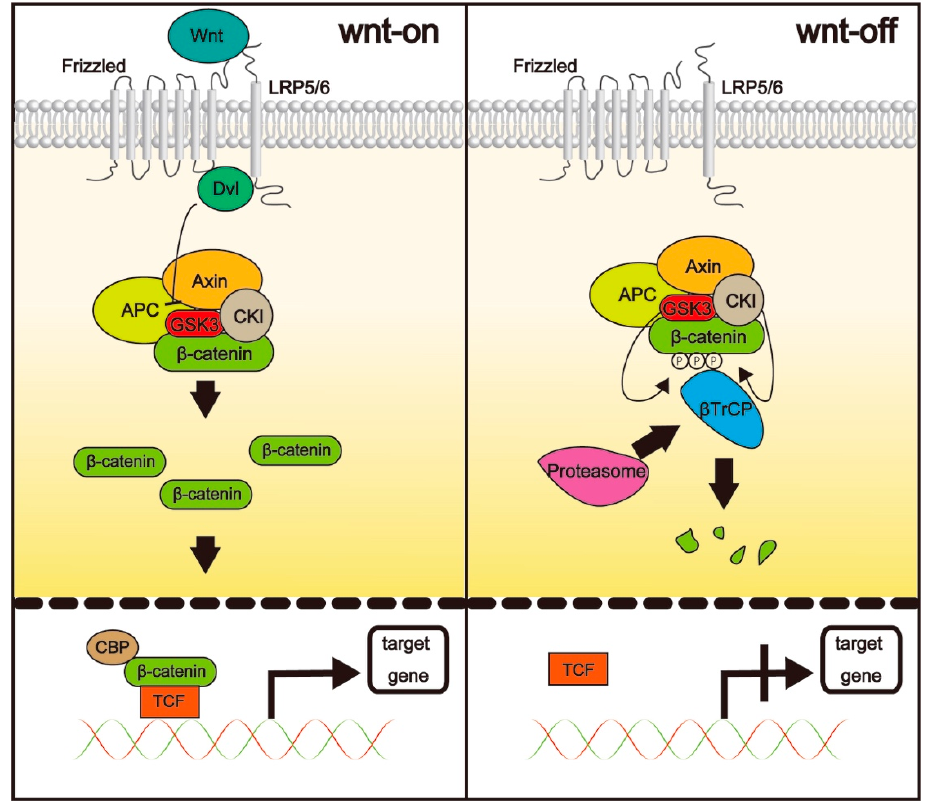
Figure 2. In the presence of Wnt, Dishevelled (Dvl) prevents β -catenin phosphorylation by inhibiting glycogen synthase kinase 3 β (GSK3 β ) activity. β -catenin is stabilized and migrates to the nucleus, where it binds to T cell factor (TCF). In the absence of Wnt signaling, β -catenin is phosphorylated by GSK3 β and casein kinase 1 α (CK1 α ) and subsequently ubiquitinated by β -transducin repeat containing protein ( β TrCP). Finally, β -catenin is degraded by the proteasome.